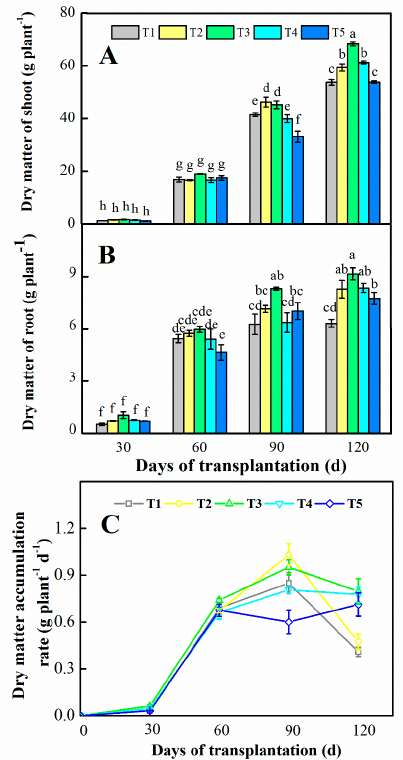
Figure 1. Dry matter of the shoot ( A ), root ( B ) and dynamic changes of dry matter accumulation rate ( C ) of pepper plants as affected by different NH 4+ :NO 3 − ratios. T1 (NH 4+ :NO 3 − = 0:100), T2 (NH 4+ :NO 3 − = 12.5:87.5), T3 (NH 4+ :NO 3 − = 25:75), T4 (NH 4+ :NO 3 − = 37.5:62.6), and T5 (NH 4+ :NO 3 − = 50:50). Vertical bars represent mean ± SE ( n = 3, each replicate consisted of 6 pepper plants) and the different letters of ( A ) and ( B ) denote significant differences ( p < 0.05).